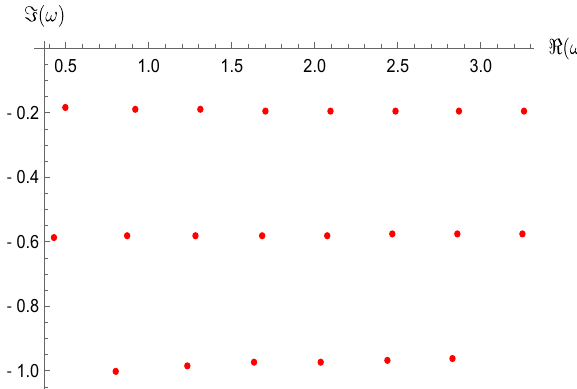
It is observed that both functions peak at integer multiple